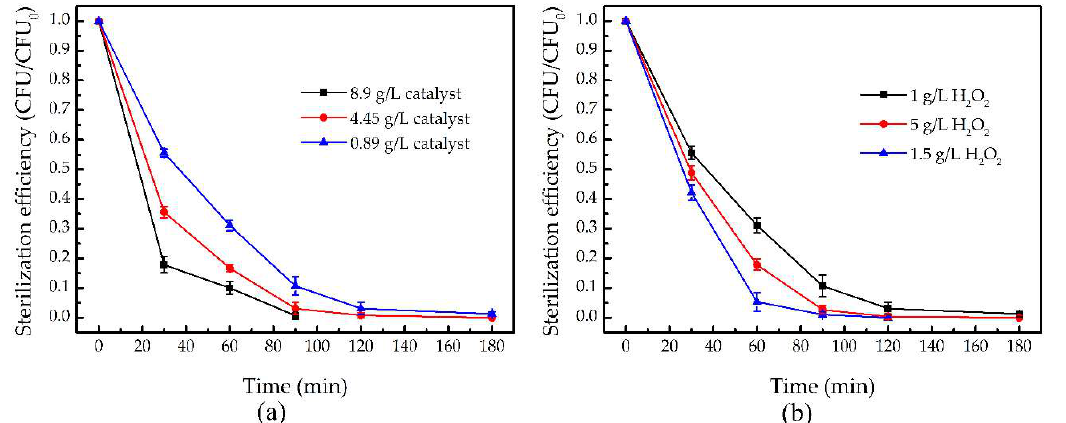
Figure 7. Effect of ( a ) the catalyst dosage and ( b ) the H 2 O 2 concentration on Pseudomonas inactivated. Reaction conditions: ( a ) [H 2 O 2 ] 0 = 5 g/L; ( b ) [Goethite] = 0.89 g/L.